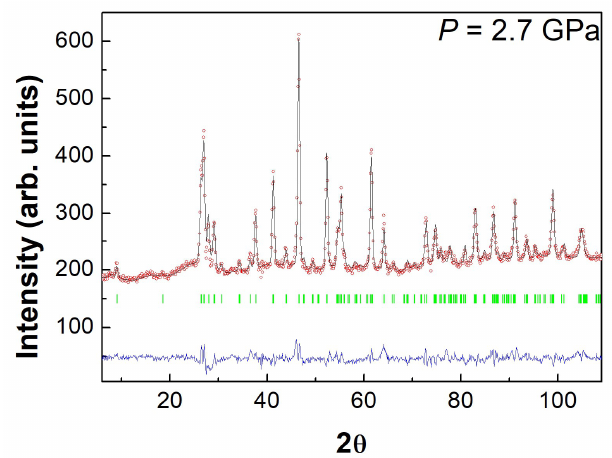
Figure 8. Rietveld refinement of LuFe 2 O 4 neutron powder diffraction data at P = 2.7 GPa. Experimental data are represented by open circles using the calculated profile by a continuous line, and the allowed structural Bragg reflections by vertical marks. The difference between the experimental and calculated profiles is displayed at the bottom of the graph. Table 1. Structural data of LuFe 2 O 4 at P = 2.7 GPa obtained by neutron powder diffraction data.